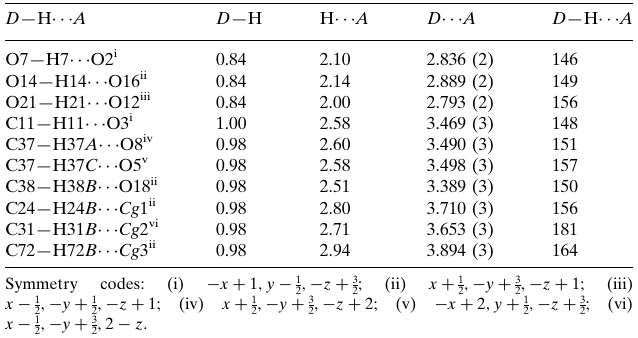
Hydrogen-bond geometry (A˚ , (cid:1)